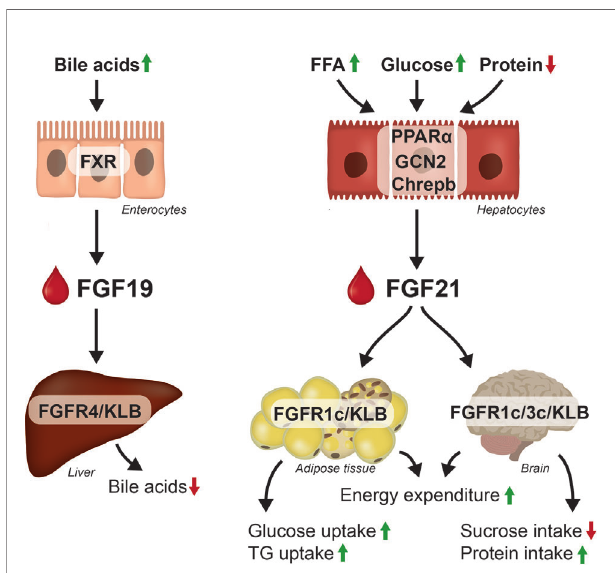
FIGURE 2 | Regulation and effect on FGF19 and FGF21. FGF19 is released from the enterocytes in response to bile acids and suppresses bile acids synthesis in hepatocytes. FGF21 is mainly expressed in hepatocytes in response to FFA, glucose and lack of amino acids. FGF21 acts in the CNS and in the adipose tissue to control glucose, lipid and energy metabolism, by increasing glucose and TG uptake into the adipose tissue, by increasing EE and altering food